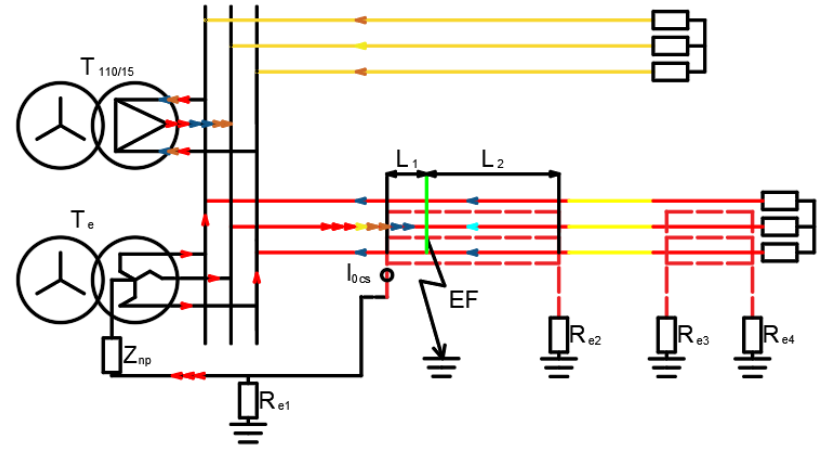
Figure 8. The idea of reverse self-current (capacitive) and reverse self-induced (capacitive) current.